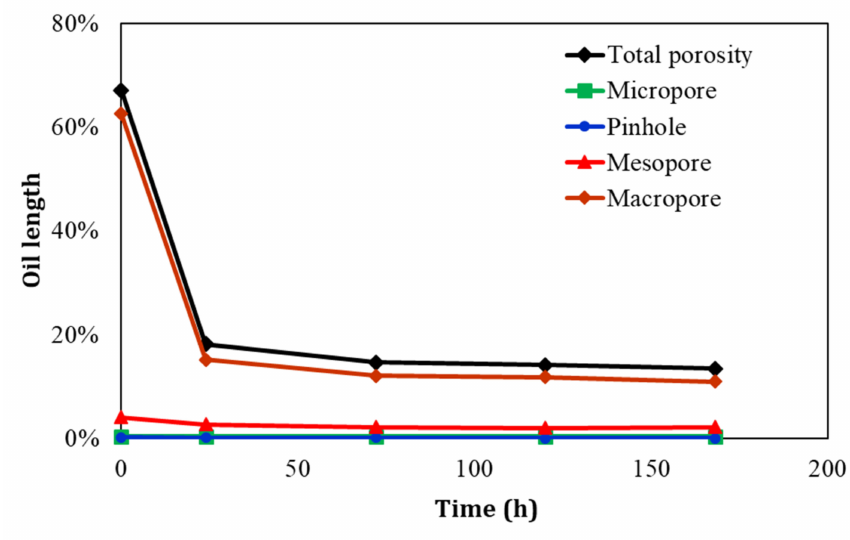
Figure 9. The time-varying curves of oil length in core 2 different levels of